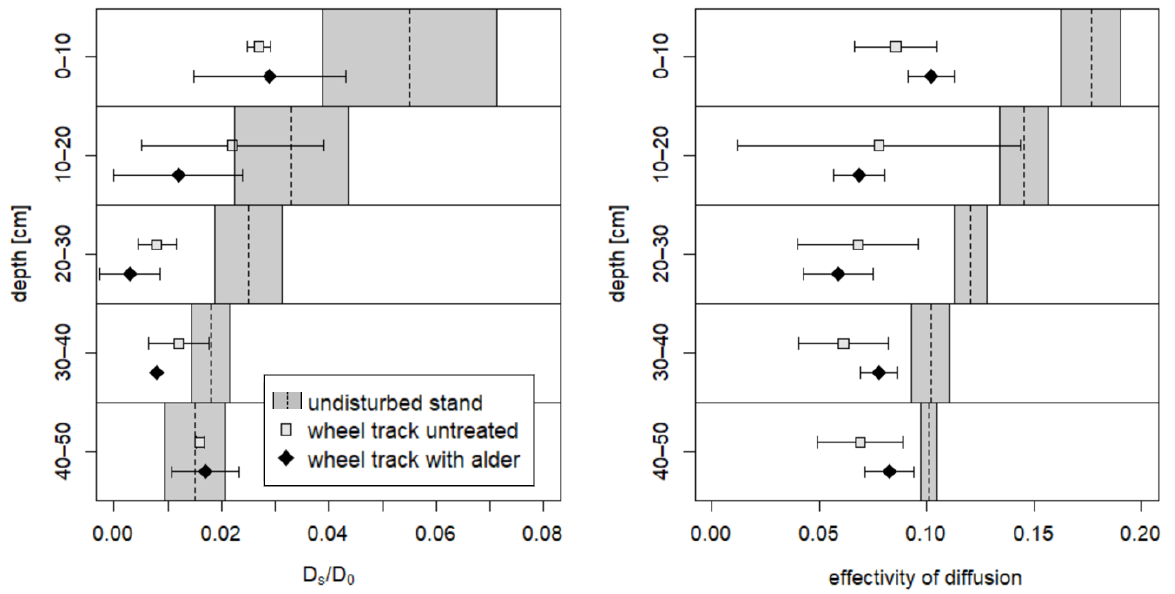
Figure 3. Median values of the relative diffusion coefficient ( D s / D 0 ) at pF 2.2 ( left ) and efficiency of diffusion at pF 2.2 ( right ) in the undisturbed beech stand (dashed lines) and on the wheel tracks of the skid trails 10 years after soil trafficking. The grey shading and error bars indicate the 95% confidence intervals of median values.